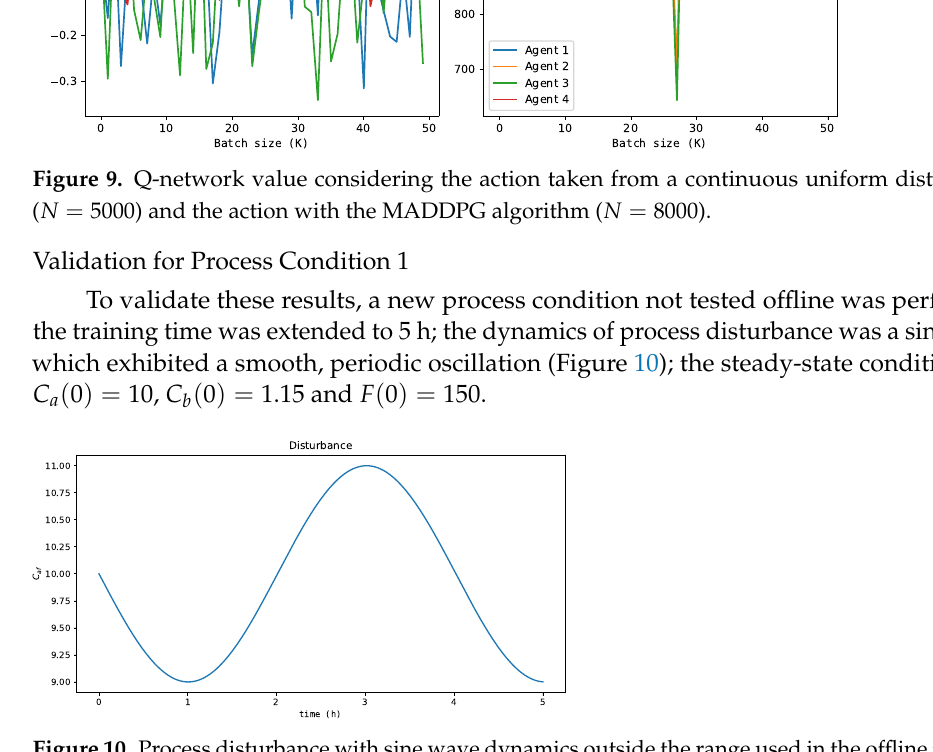
Figure 10. Process disturbance with sine wave dynamics outside the range used in the offline